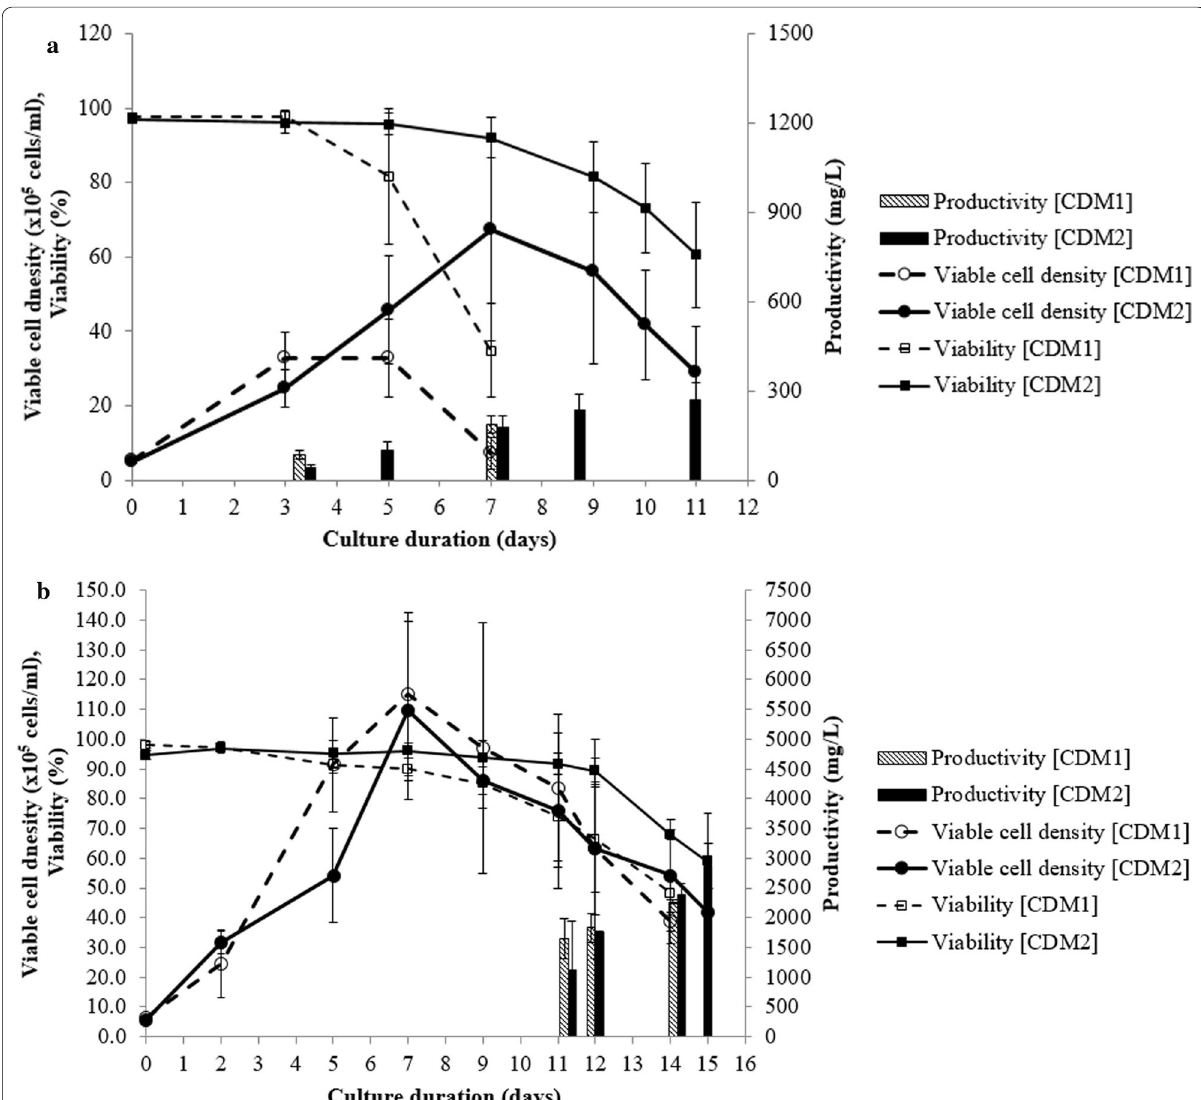
Fig. 5 Comparing cell culture data of CDM1 derived clones and CDM2 derived clones a batch culture (no feed) data of top clones from CDM1 and CDM2 (average of 20 clones, error bar is standard deviation), b fed-batch culture of top clones from CDM1 and CDM2 (average of 3 clones, error bar is standard deviation), CDM1 data used CDM1 as basal media and CDM2 data uses CDM2 as basal media, for fed-batch the same feed cocktail (Cell Boost 7a and 7b) is used in both CDM1 and CDM2 data at the same